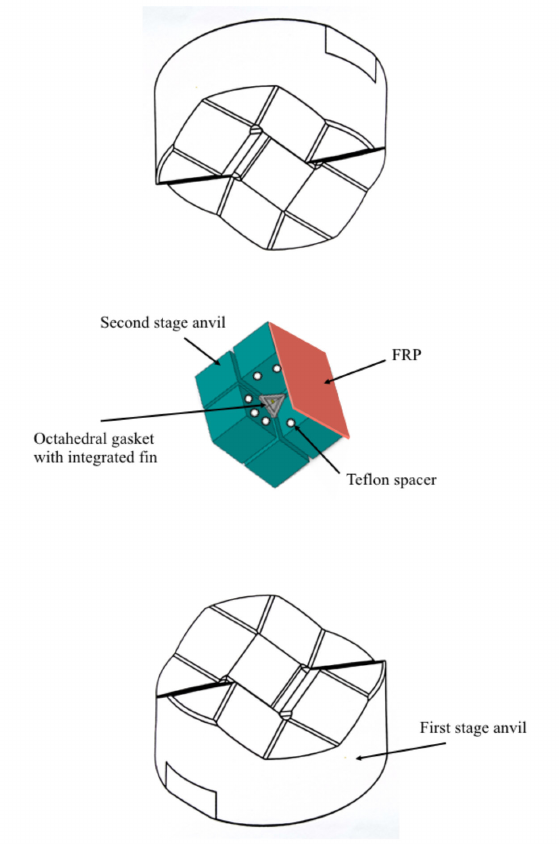
Figure 1: Schematic illustration of the first-stage and second-stage